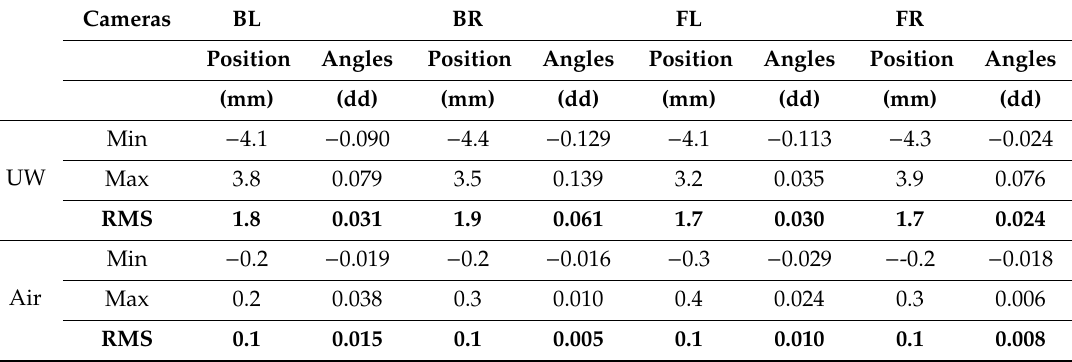
Table 7. EOP di ff erences (min, max, RMS) of all cameras underwater (UW) and in-air when applying the CMB adjustment.